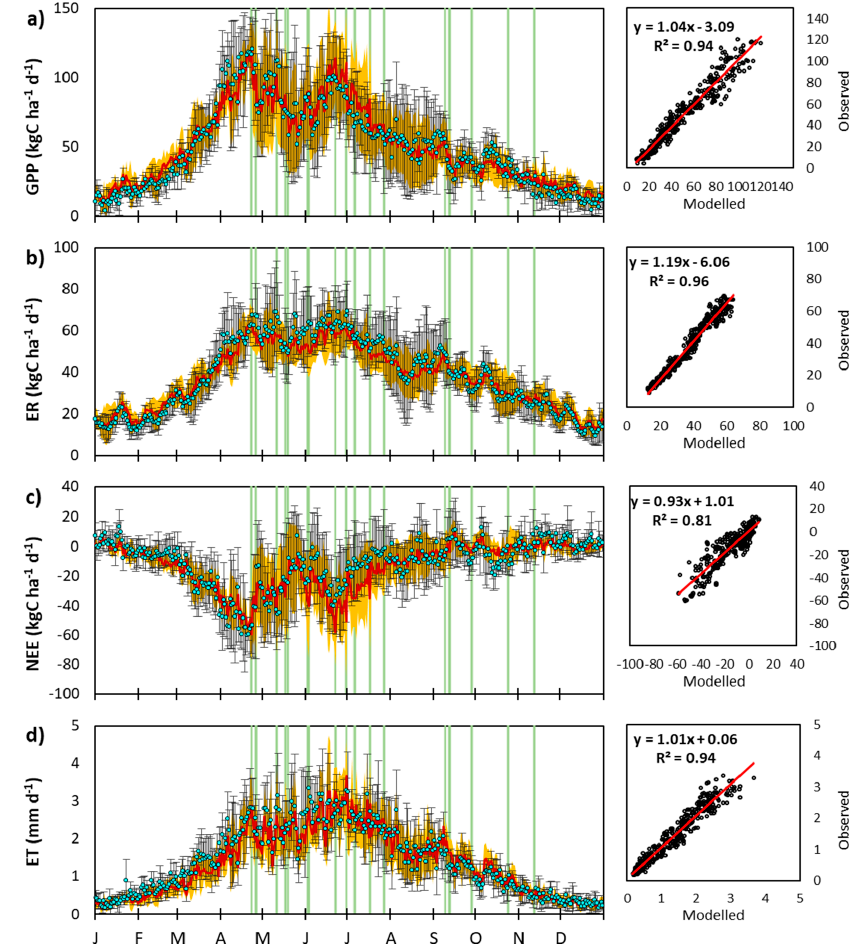
Figure 8. Daily carbon and water fluxes averaged for each day of the year over the study period (2006–2010) for the mowed pasture. The blue circles are used for observations, error bars represent one standard deviation around observed means; the red line is used for CenW modeled fluxes; and the yellow shaded areas represent one standard deviation around modeled means. GPP ( a ), ER ( b ), NEE ( c ), and ET ( d ).